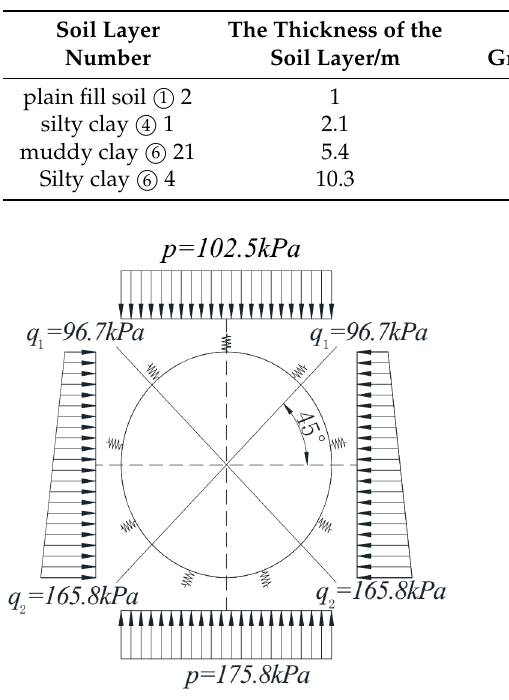
The Thickness of the Soil Layer/m